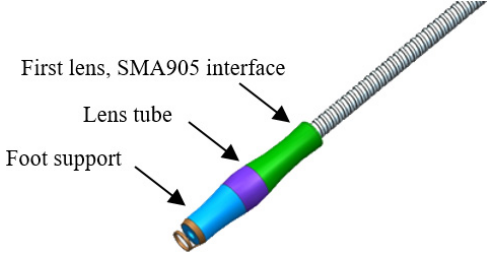
Fig. 5. Schematic diagram of the treatment handpiece.